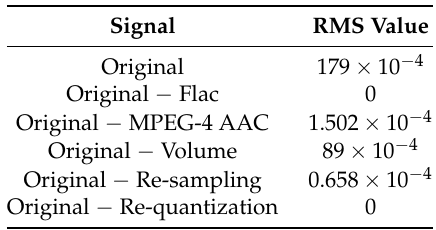
Table 5. Example of perceptual manipulations for original signal shown in Figure 4a: RMS (root mean squared) values of original signal and original minus modified signal.